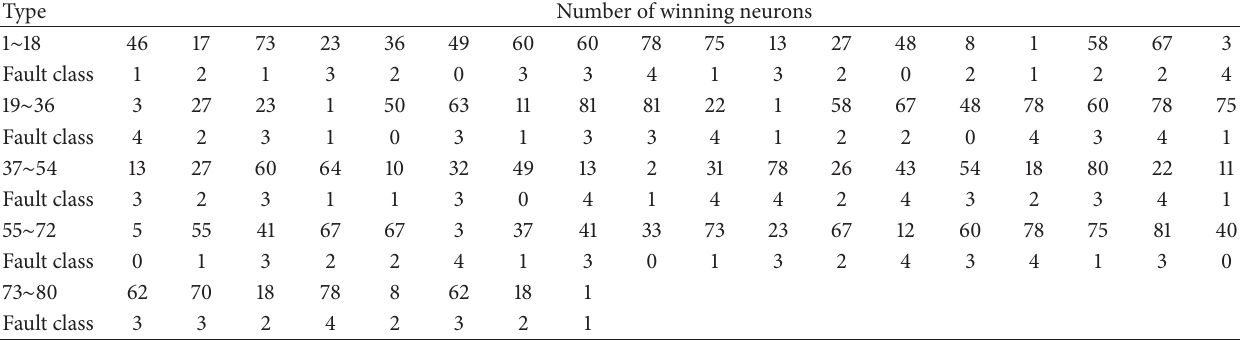
Table 6: Comparison between actual values and predicted values of SOM neural network optimized by PSO algorithm. Type